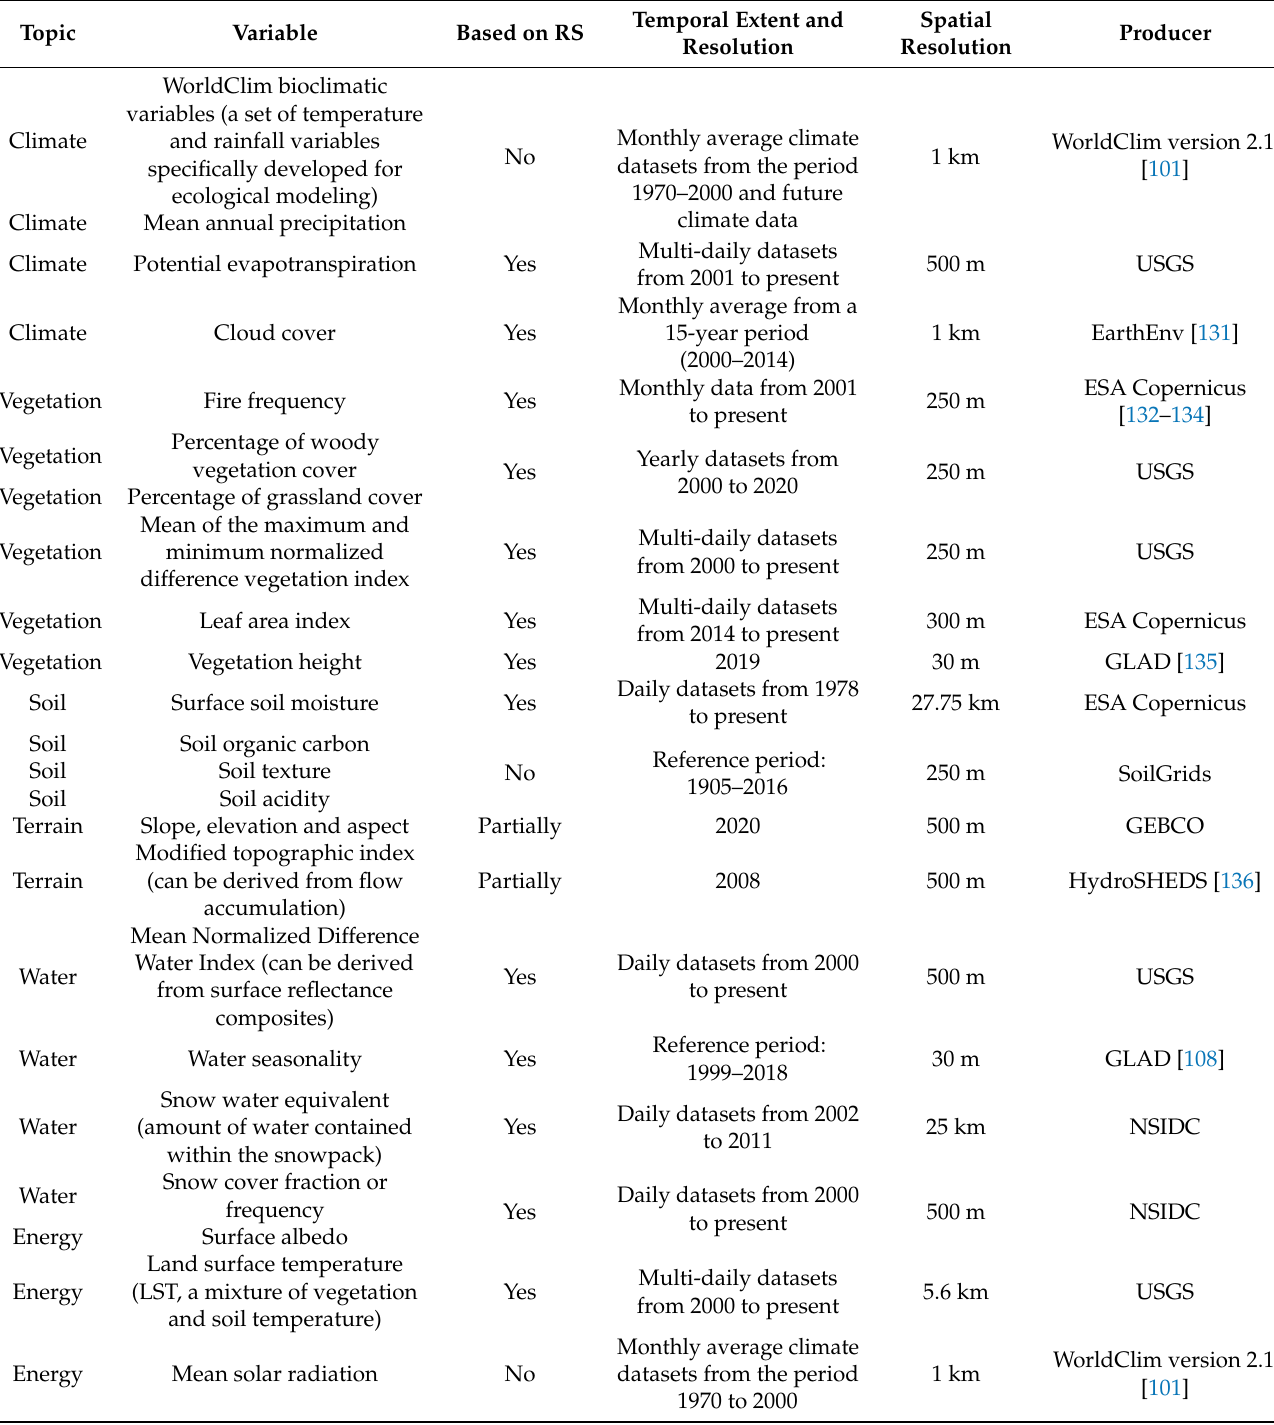
Table 1. Relevant biophysical input variables that can be used for the characterization of terrestrial protected areas at a global scale. Acronyms used: NASA; National Snow and Ice Data Center (NSIDC); U.S. Geological Survey (USGS); European Space Agency (ESA); Global Land Analysis and Discovery (GLAD); hydrological data and maps based on Shuttle elevation derivatives at multiple scales (HydroSHEDS); General Bathymetric Chart of the Oceans